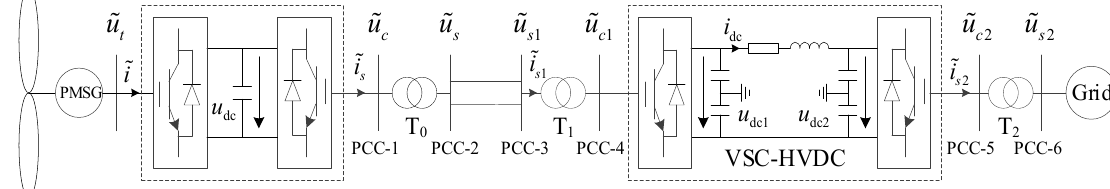
Figure 2. The Drive Permanent Magnet Synchronous Generator (D-PMSG) via Voltage Source Converter-based High-Voltage Direct Current (VSC-HVDC) grid-connection system model.